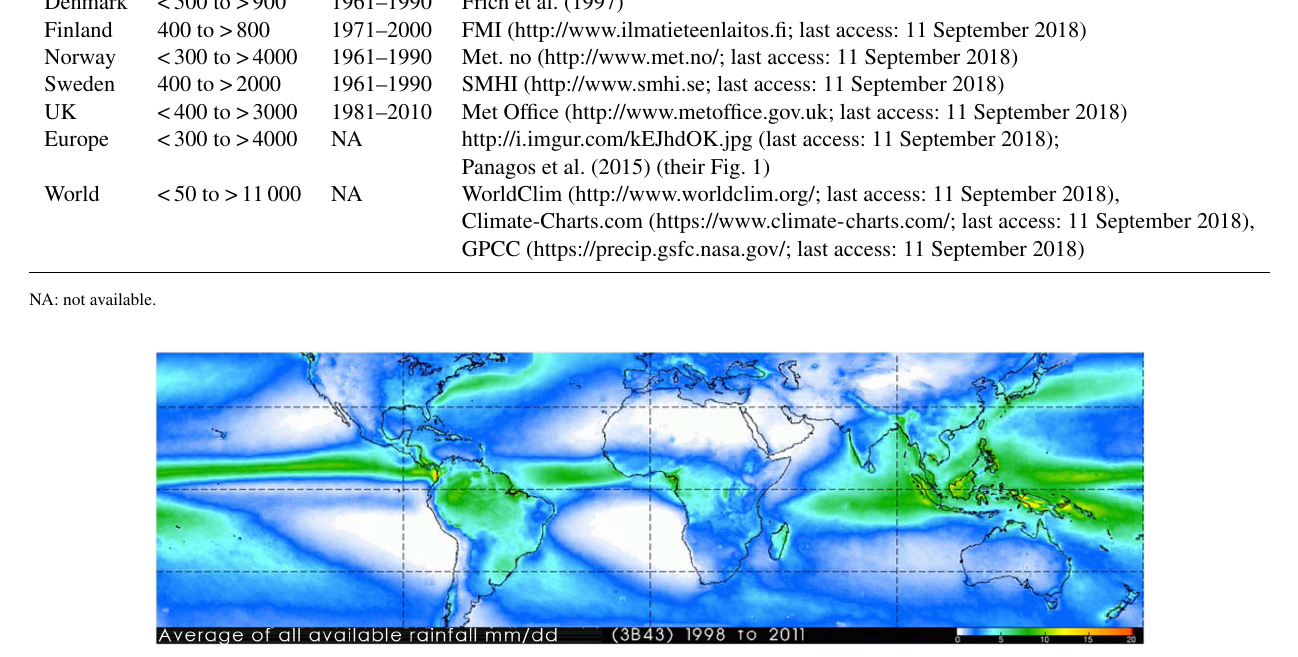
Figure 9. Average rainfall measured by TRMM from 1998 to 2011. Source: NASA (2018).